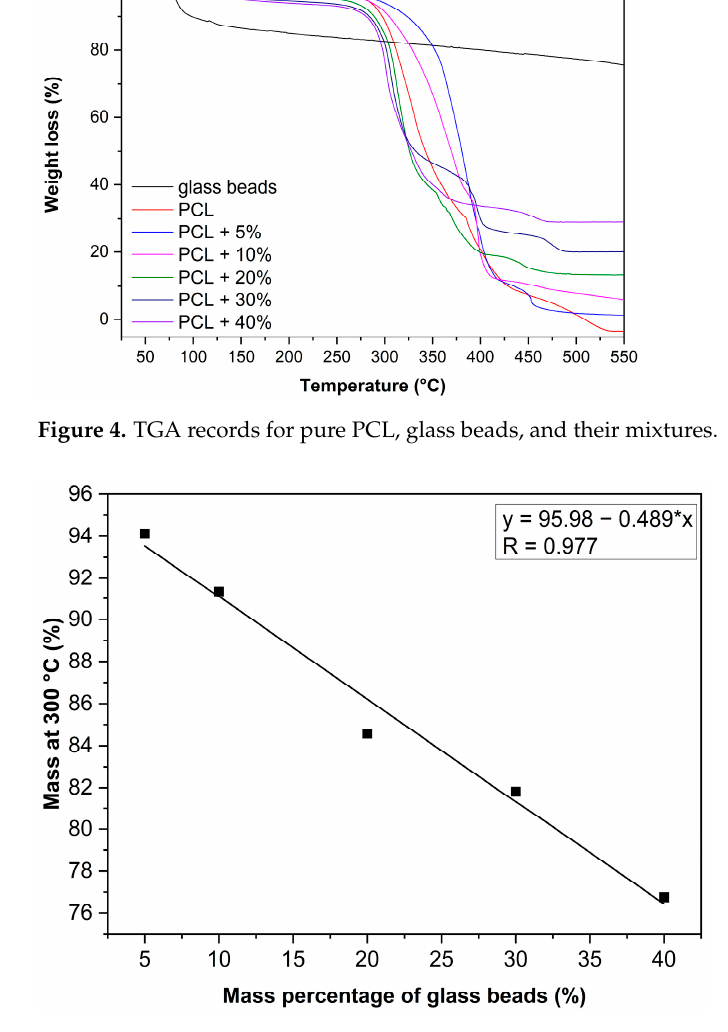
Figure 5. The linear regression of mass at 300 °C (%) dependence on the mass percentage of glass beads (%).